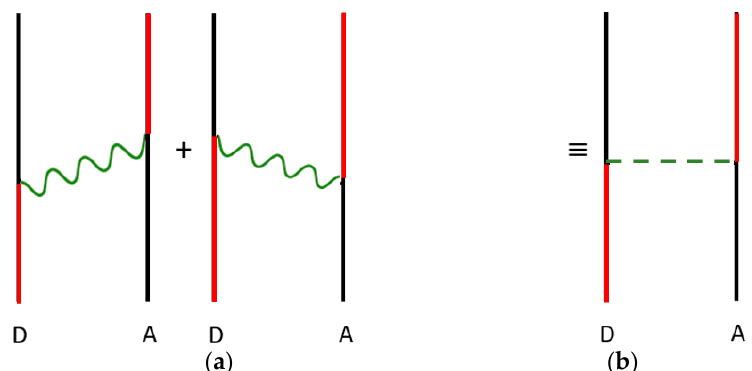
Figure 1. Graphs for calculating the basic matrix element for electronic energy transfer, in which